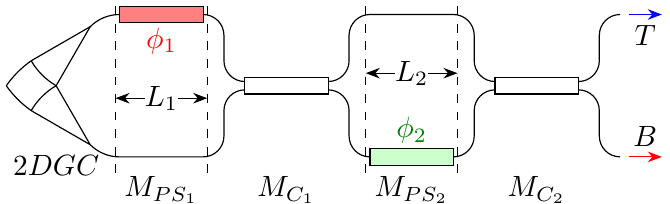
Figure 1. Schematic of the integrated polarisation controller. The labels M i refer to the transfer matrix associated with a given circuit section. The block on the picture leftmost portion is a schematic of the 2DGC. The “T” and “B” labels denote the top and bottom outputs,